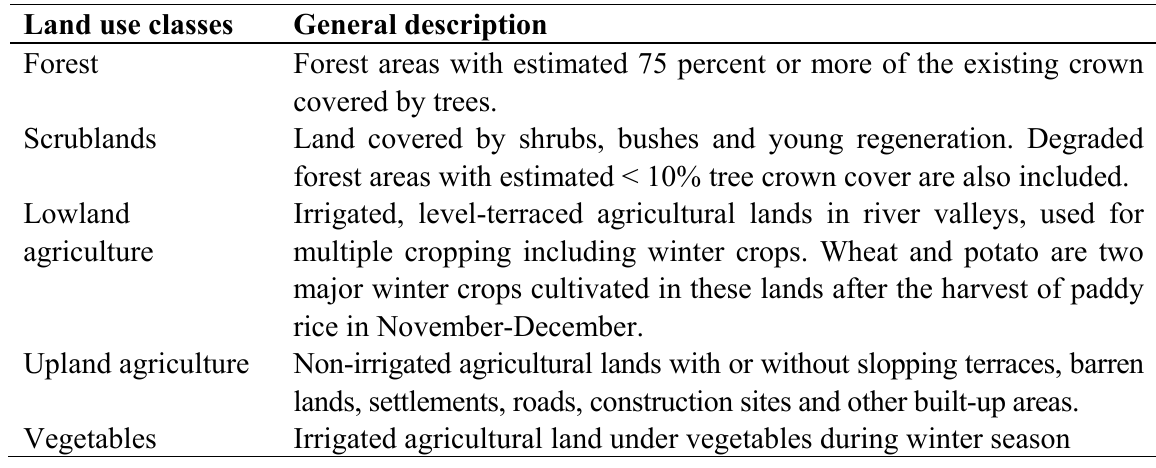
Table 2. Land use classes considered in image classification and changes